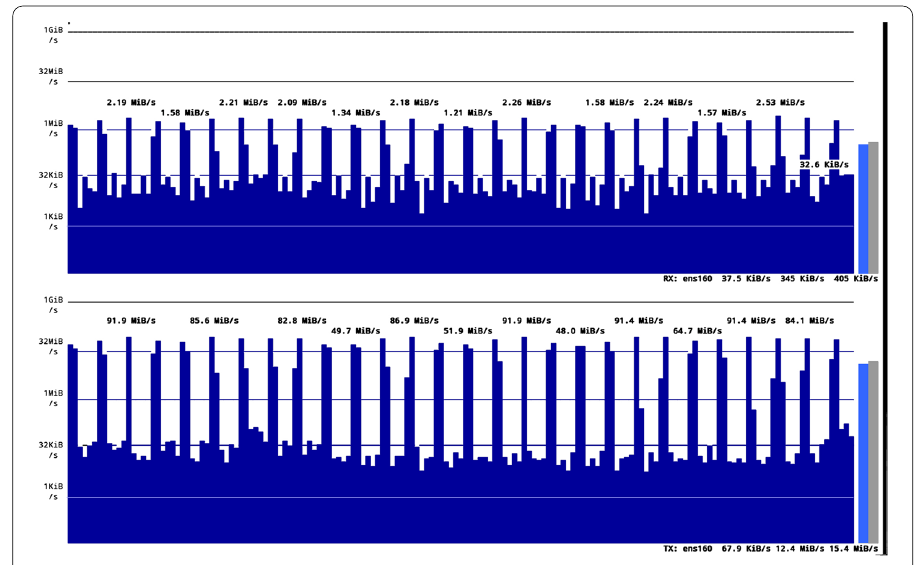
Fig. 13 Network utilization for peer process with 100 models of 100